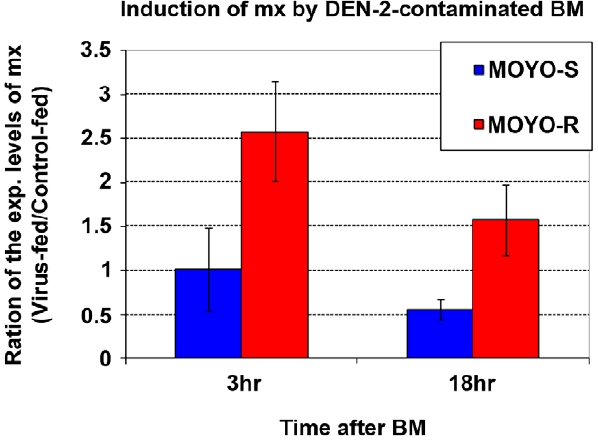
Figure 6. Specific induction of mx in the refractory strain (MOYO-R), but not in the susceptible strain (MOYO-S), following exposure to DEN-2. The expression level of mx was measured by Q-PCR and normalized against the housekeeping gene GAPDH before calculating the fold induction, i.e. the ratio of mx in virus- fed vs. the control-fed samples. At 3 hr post feeding, the level of mx in adult A. aegypti females exposed to DEN-2 was more than 2 fold higher than those fed with control blood meal. This level of mx expression declined at 18 hr, possibly due to death of mx -expressing cells as was previously observed for CuniNPV -infected A. aegypti larvae. Data are represented as mean 6 SD.